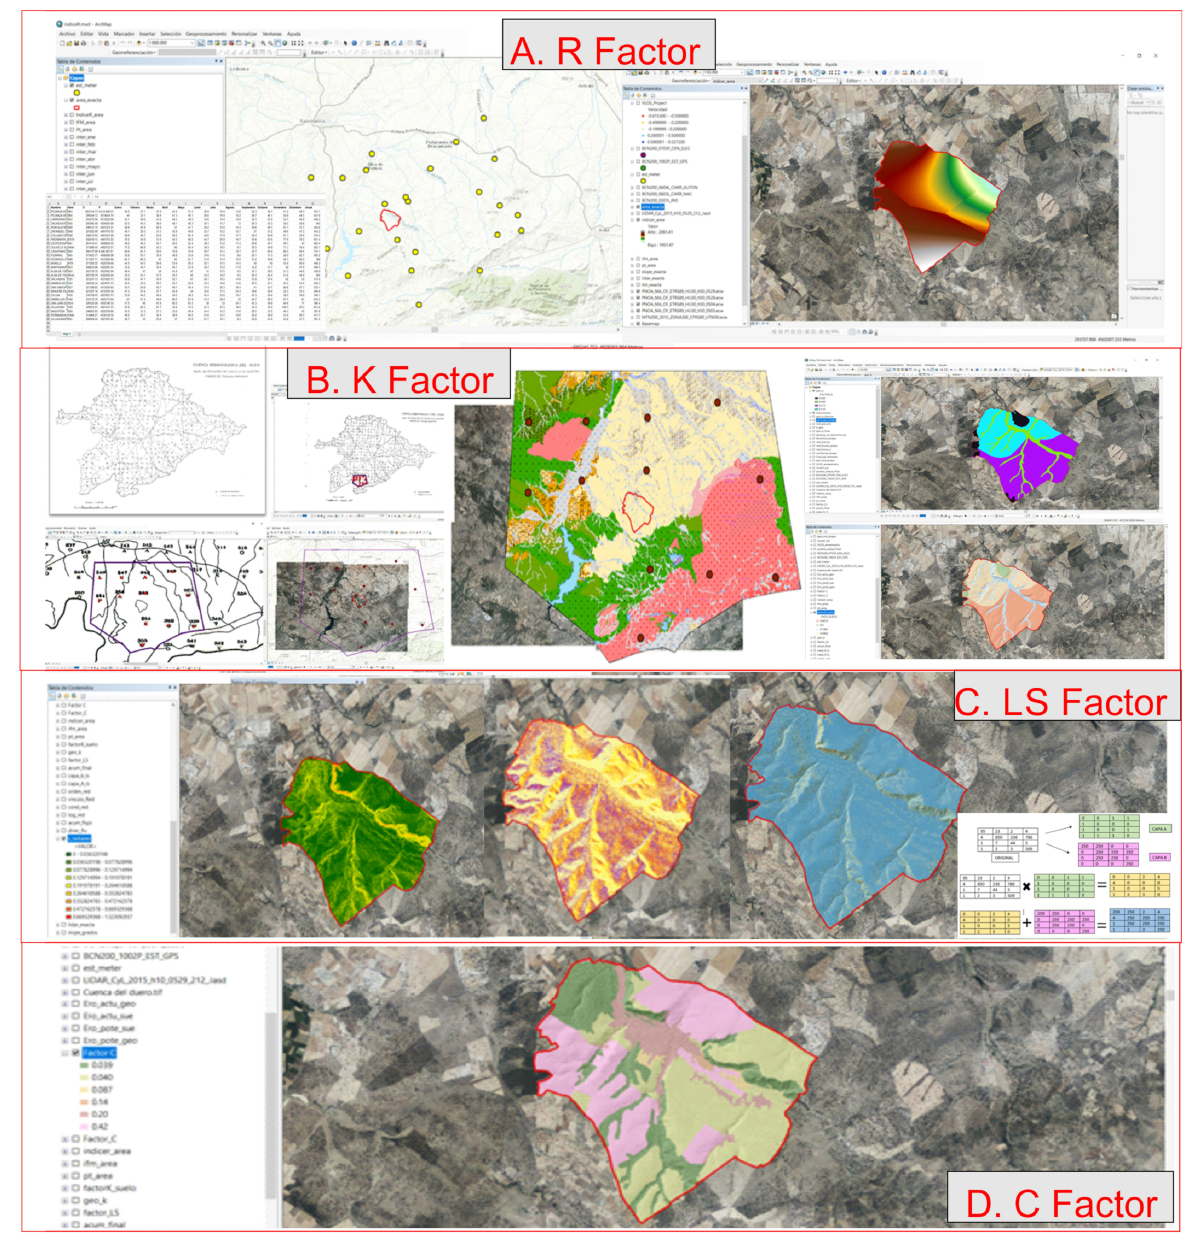
Figure 6. Calculation procedures for R factor (File A ), K factor (File B ), LS factor (File C ) and C factor (File D ).